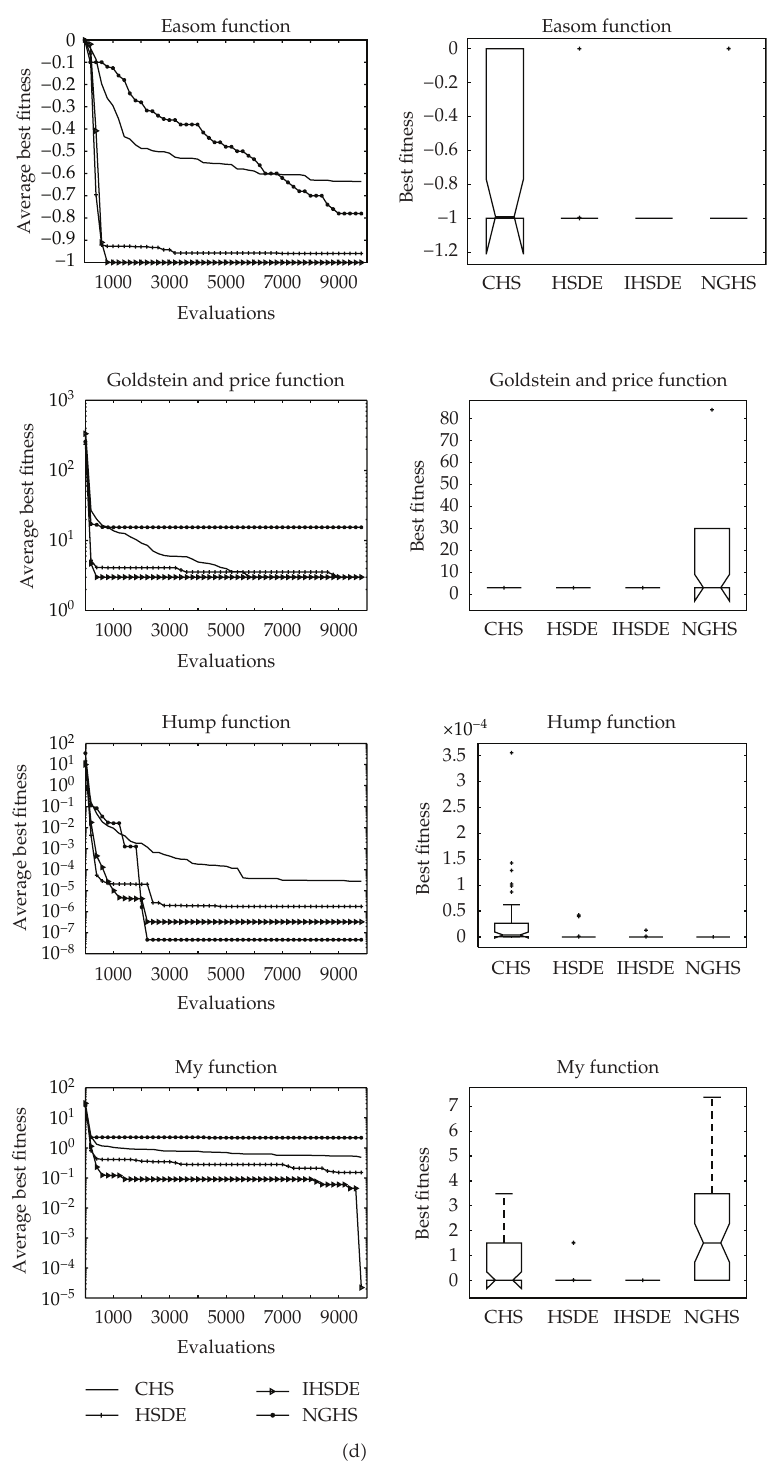
Figure 2: The convergence and its